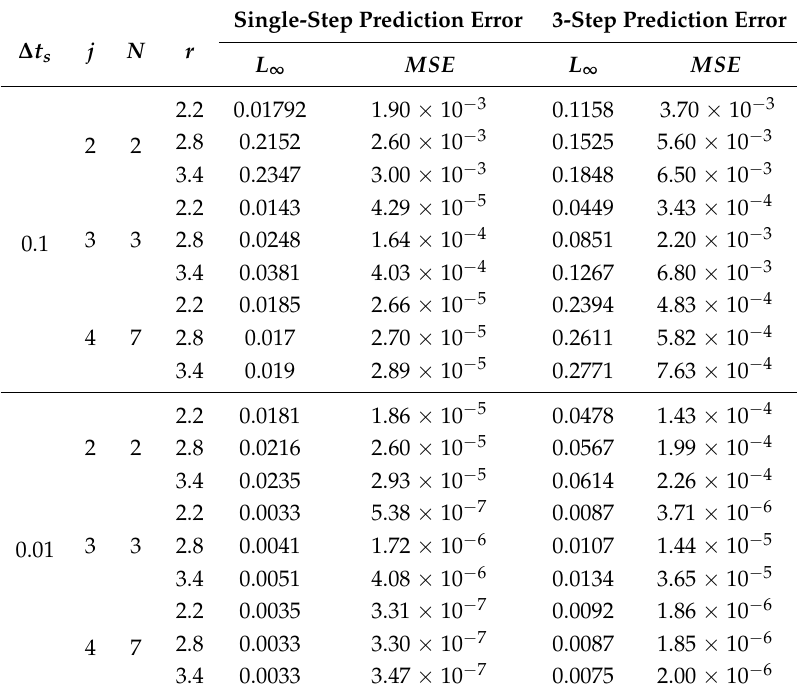
Table 1. The prediction performance obtained by the proposed